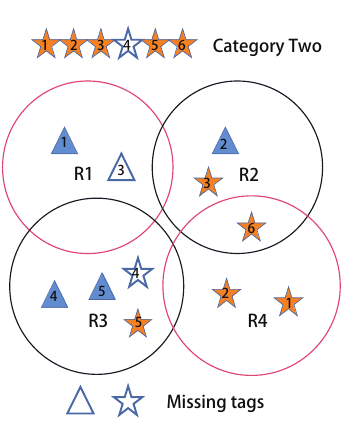
Figure 1. System